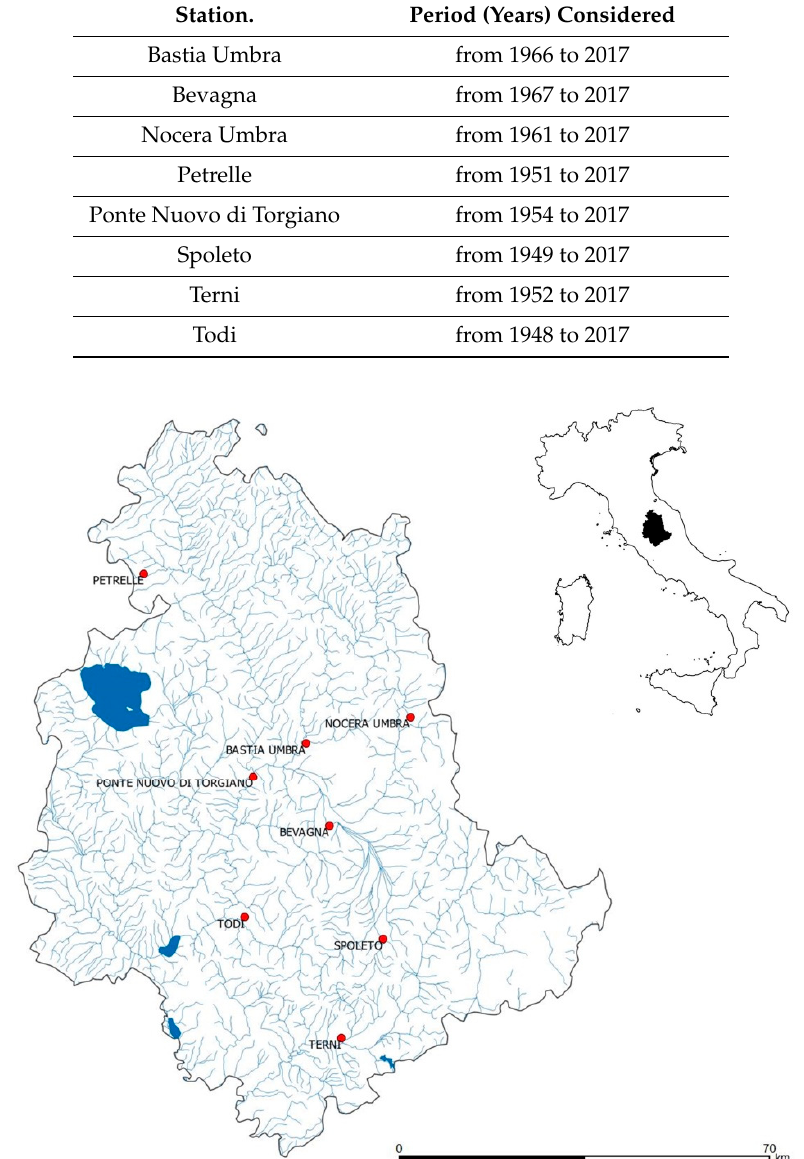
Figure 1. Rain gauges in the Umbria region used in this work.